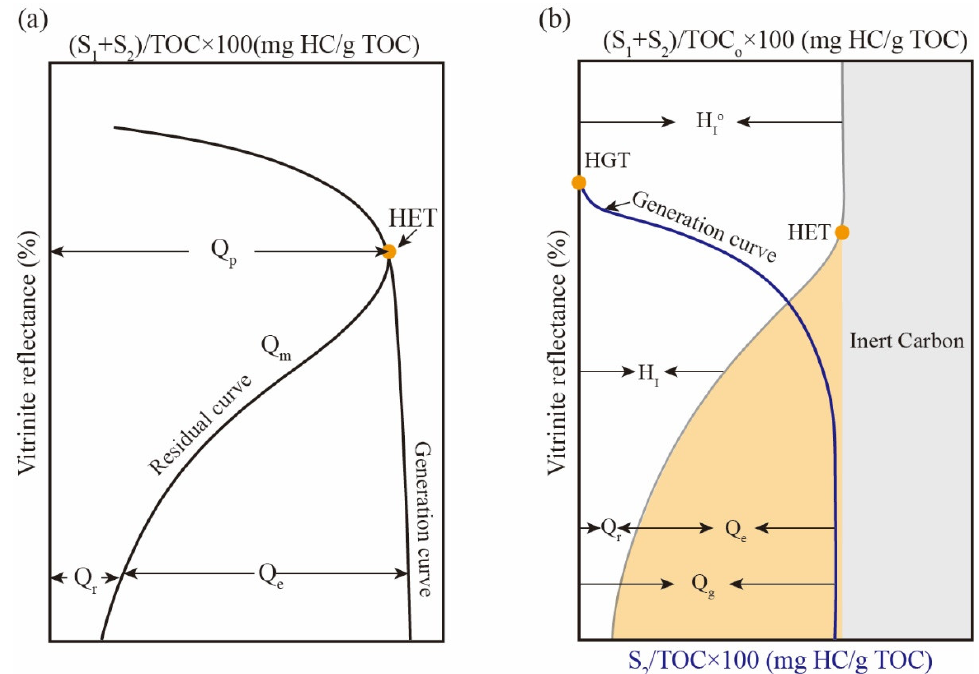
Figure 2. Detailed comparison between the original hydrocarbon generation potential model (HGPM) and the HGPM adapted in this study. ( a ) original HGPM proposed by Pang et al. [13] ( b ) HGPM revised by Wang et al. [26].